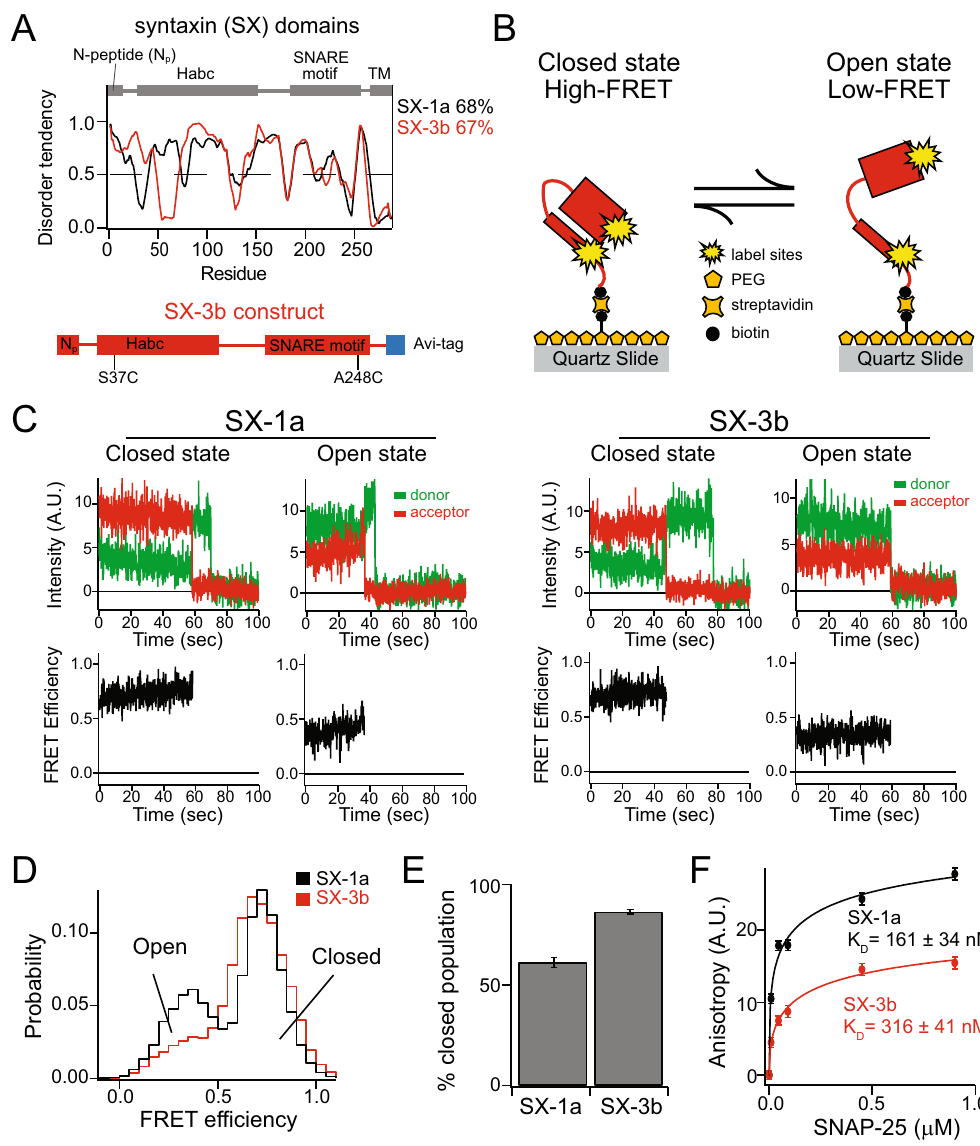
Figure 1. Native state conformations of syntaxin-1a and syntaxin-3b. ( A ) The disorder tendencies of syntaxin-1a and -3b are analyzed by PONDR VLXT 25 . The protein domain diagram illustrates the common domains of syntaxin-1a and syntaxin-3b (top panel) and the syntaxin-3b construct used in this experiment (bottom panel). ( B ) Schematic of a surface-tethered syntaxin molecule labeled with FRET dye pairs on a functionalized surface of a microscope slide in a closed and open conformation leading to high and low FRET efficiency, respectively. ( C ) Representative single-molecule fluorescence intensity time traces of sytnaxin-1a (SX-1a) and syntaxin-3b (SX-3b) in the closed and open conformations (top panels). The donor and acceptor intensities were converted to FRET efficiency time traces (bottom panels). ( D ) smFRET efficiency histograms of isolated SX-1a and SX-3b. ( E ) Percent closed populations of SX-1a and SX-3b were extracted from (D) by fitting two Gaussian functions to the FRET efficiency histograms. Shown are means ± SD ( n = 3). ( F ) Bulk fluorescence anisotropy measurements of interactions between Alexa 488 labeled syntaxins and unlabeled SNAP-25 at 0 μM, 0.009 μM, 0.045 μM, 0.090 μM, 0.450 μM, 0.900 μM concentrations. The anisotropy curves are fit with Hill equations to estimate the disassociation constant K d . Shown are means ± SD ( n =